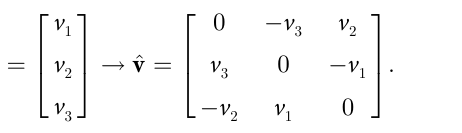
Fig 1. Initial and time-evolved configurations of the continuum manipulator. The highlighted frames depict cross- sections at discretization points. Fixed bases or material frame f E manipulators. Also, moving bases f D manipulators.